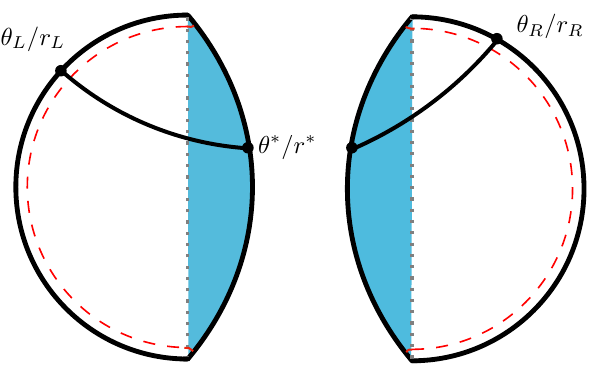
Figure 8. Defect AdS geometry consisting of two AdS patches glued together along lines of constant y = y (cid:3) at the location of the defect. The spacelike geodesic connecting (cid:18) L and (cid:18) R (alternatively (cid:6) r L and r R ) will pass through (cid:18) = On the right patch we have extended the de(cid:12)nition of r in both patches such that all the patch is covered and Angles are measured with respect to the vertical upward